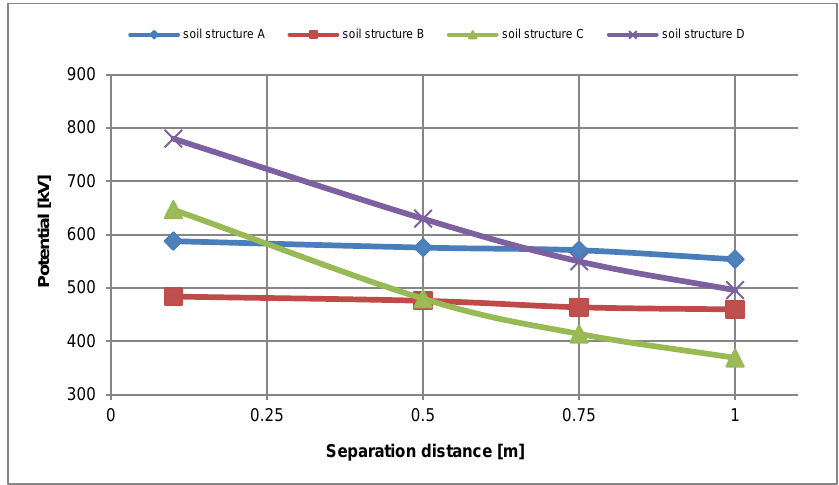
Figure 5. Maximum values of the soil surface potential calculated at a 1 m distance from the air termination rod for different soil structures.